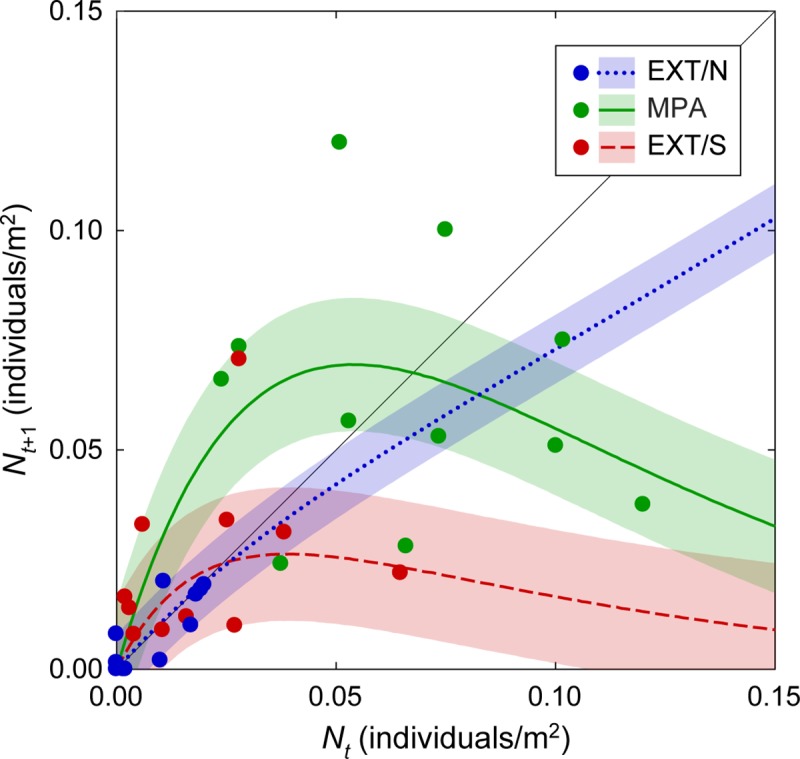
Relationship between population density of Diplodus sargus sargus in two subsequent years.Dots indicate data collected inside the protected area (MPA) and at two unprotected locations outside (EXT/N and EXT/S); colored lines and shaded areas are median and interquartile range, respectively, of multi-model predictions (weighted mean of the predictions obtained with the three best models; see text for details). Intersections between the 45° identity line and the colored lines identify equilibrium densities for the deterministic component of the model.